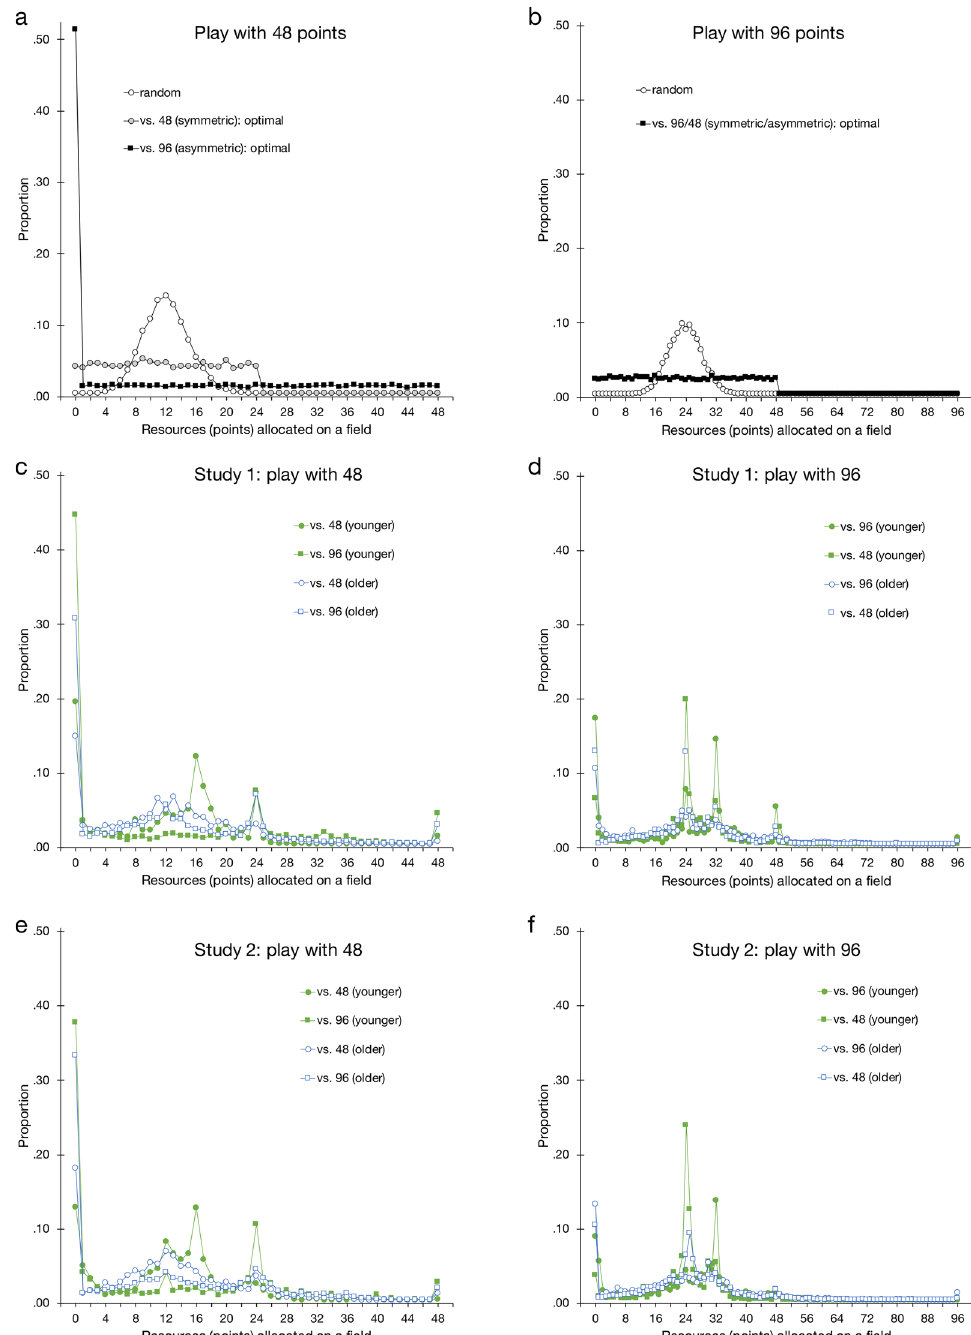
Figure 2. Proportions of allocations of a specific number of points on a field across the game for opponents of equal (symmetric) or unequal (asymmetric) strength, with either 48 or 96 points available. The upper two panels show simulated draws from game-theoretically optimal play and from random play with 48 points (panel a ) or 96 points (panel b ). The other panels plot the observed allocations of younger and older adults for Study 1 (homogeneous age groups; panels c and d ) and Study 2 (mixed age groups; panels e and f ) as a function of available points and opponent strength. For the simulations in panels a and b , we generated independent draws from distributions under optimal and random play (with n = 2000 and n = 4000 draws for the symmetric and asymmetric conditions, respectively, corresponding with the actual number of observations in each study). Random play implies that the opponents allocate their m available points unsystematically across k fields with equal probability, following a binomially distributed random variable X ∼ B